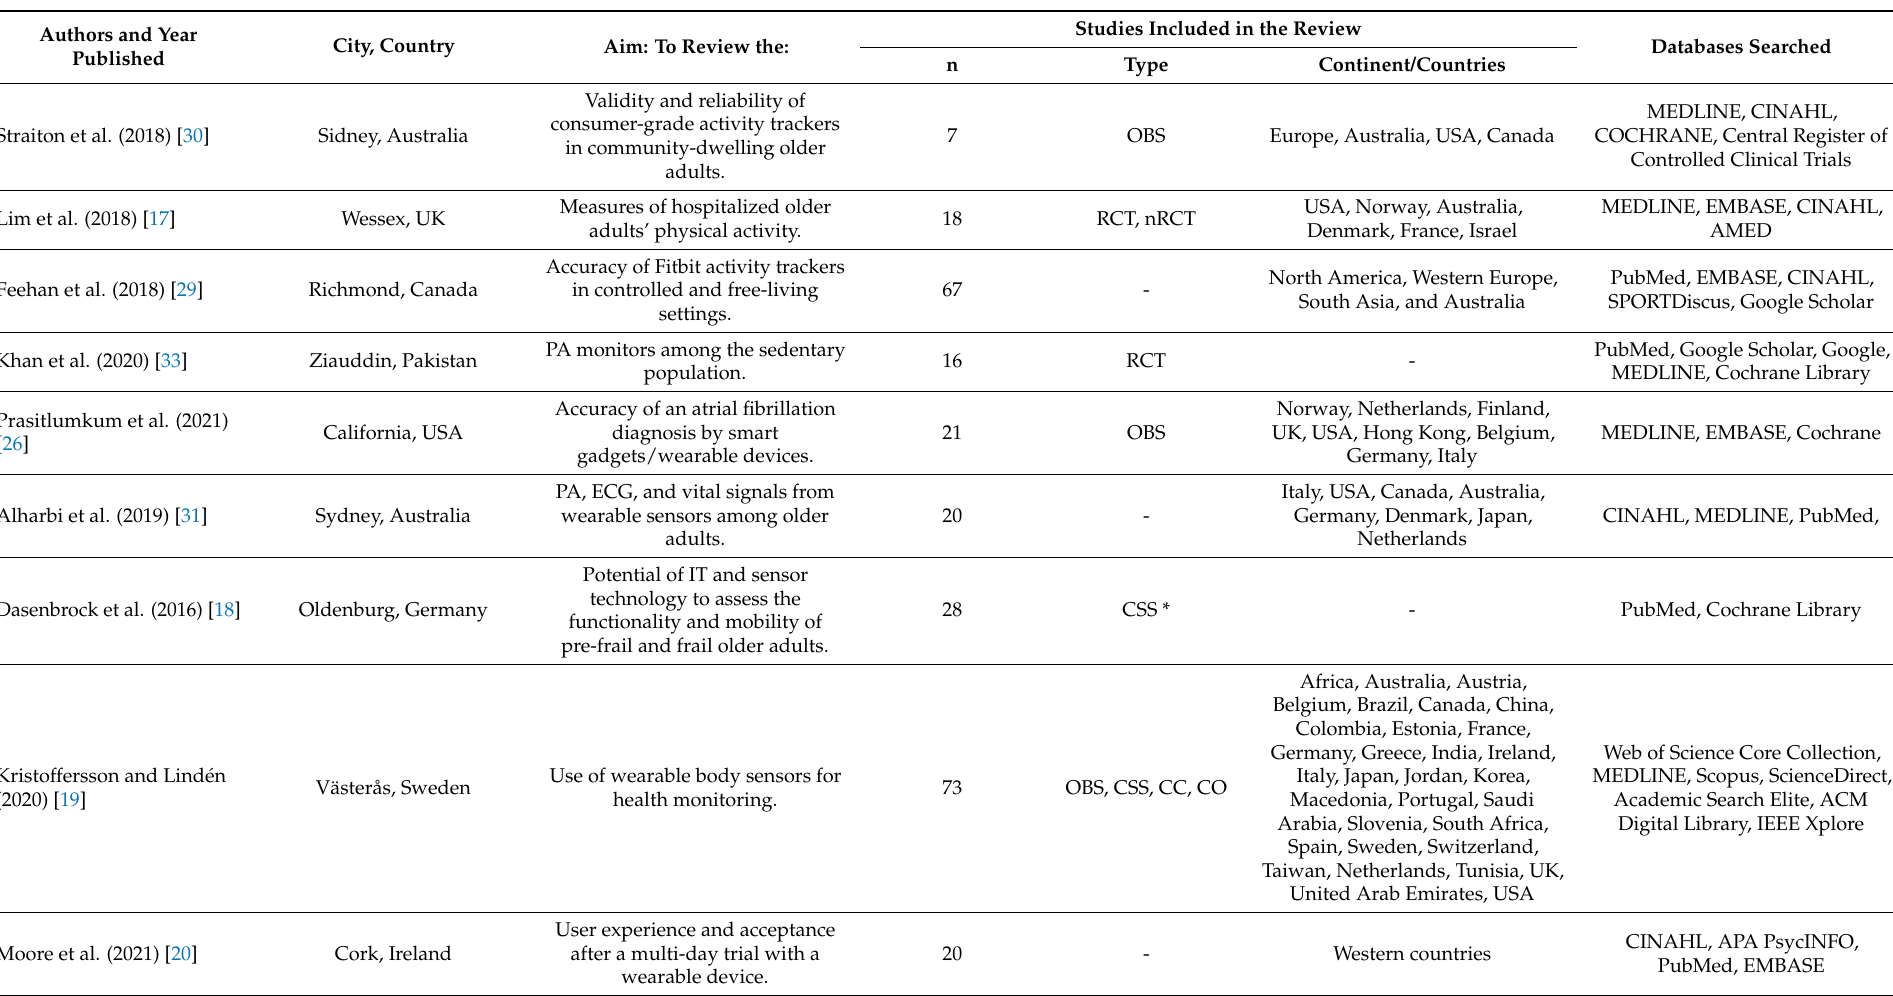
Table 1. Characteristics of each review included in this umbrella review, with the authors and year published, the city and country in which the review was conducted, the aim, the number of included studies (n) and respective countries, and the databases